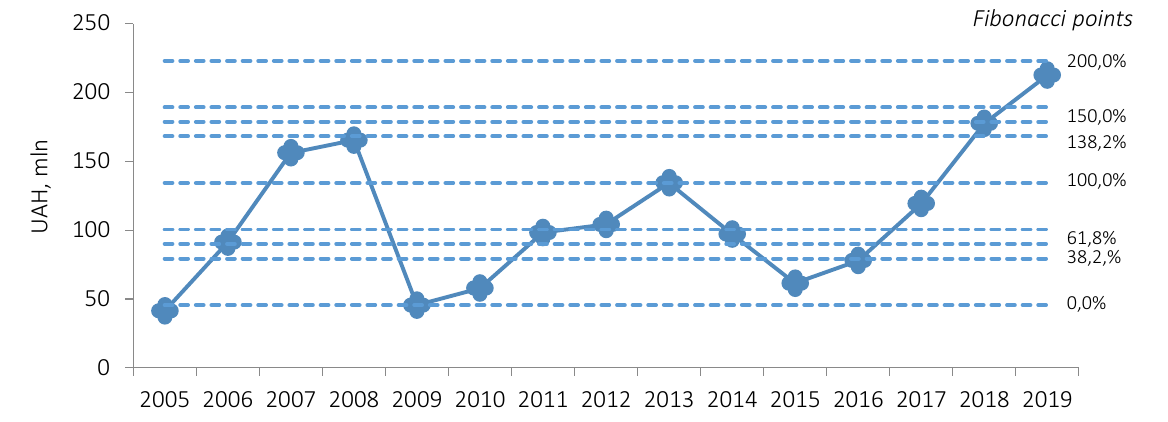
Figure 2. Growth trend of the retail loan market superimposed on the Fibonacci grid chart